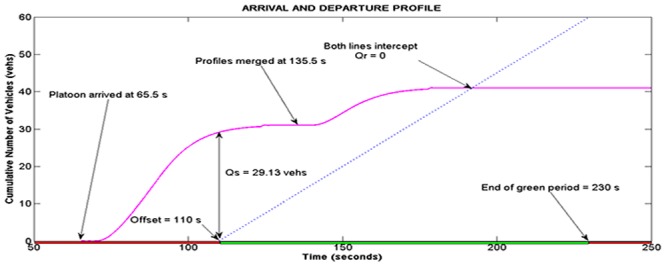
Arrival and departure profile at Intersection II.